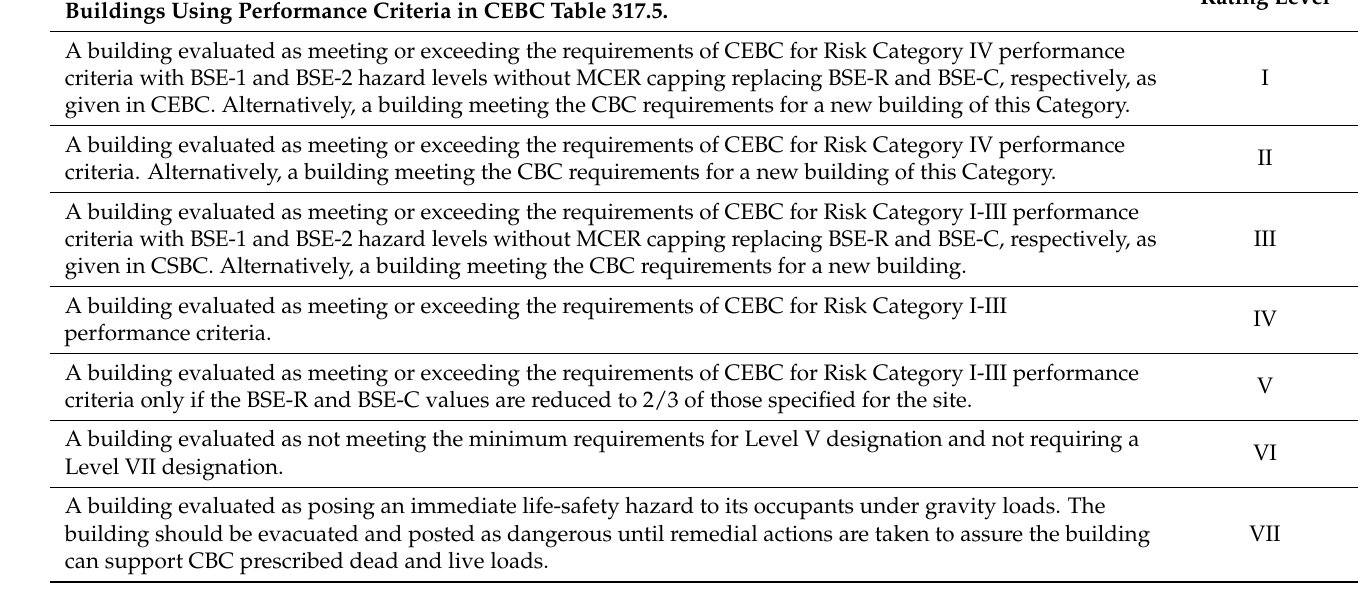
Table 5. CSU Ratings of Earthquake Performance Levels for Existing Buildings from the current edition of the CSU Seismic Policy based on level of CEBC Structural compliance, Part 10 of the CBC, (CSU 2020). The University of California also uses these definitions, as do most California State Agencies. For levels III through V, the assessing engineer can increase of decrease the rating if it is supported by the independent peer reviewer. These follow the requirements of the CEBC, where the ASCE 41 BSE-1E an BSE-2E are defined differently that they are in ASCE 41 by not allowing the capping of values by those for a new building, BSE-1 and